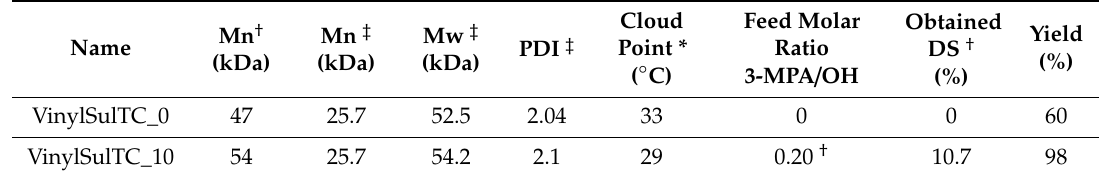
Table 1. Overview of the main characteristics of VinylSulfTC_n copolymers, as determined by 1 H-. NMR, Gel Permeation Chromatography and light scattering.